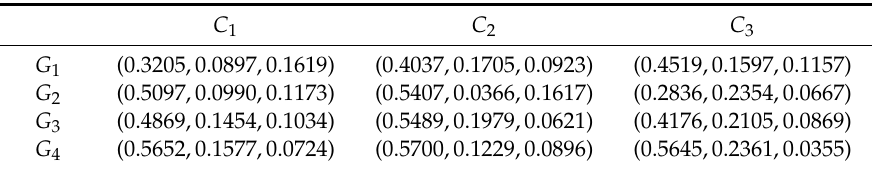
Table 11. Collective picture fuzzy information.